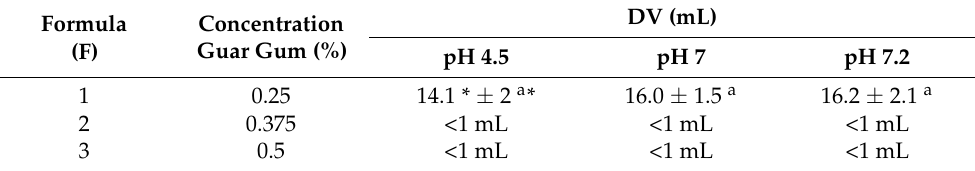
Table 4. Drainage Volume (DV) in 60 min.